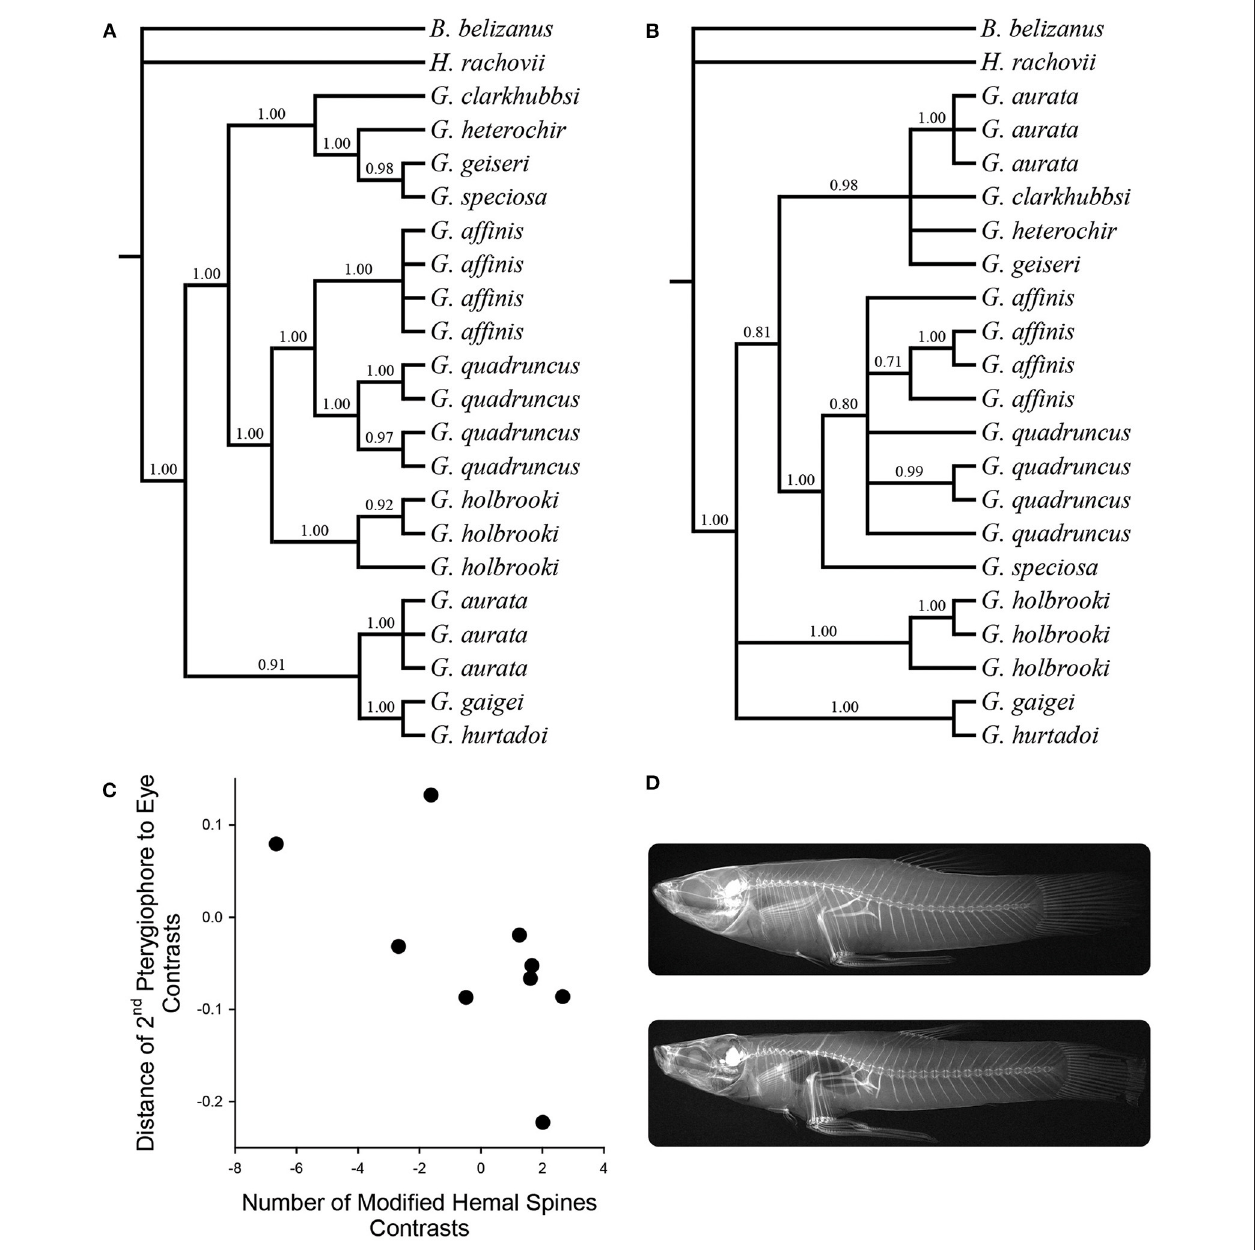
FIGURE 3 | Bayesian phylogenetic hypothesis using (A) concatenated mtDNA gene sequences and (B) the nuclear encoded S7 intron. Topologies represent 50% majority-rule consensus trees, and numbers represent Bayesian posterior probabilities of nodes. (C) Phylogenetically independent contrasts based on the S7 phylogeny, depicting correlated evolution of the relative number of modified hemal spines and gonopodial anterior transposition. (D) Representative radiographs of G. aurata (top; two modified hemal spines, weak gonopodial anterior transposition) and G. affinis (bottom; three modified hemal spines, strong gonopodial anterior